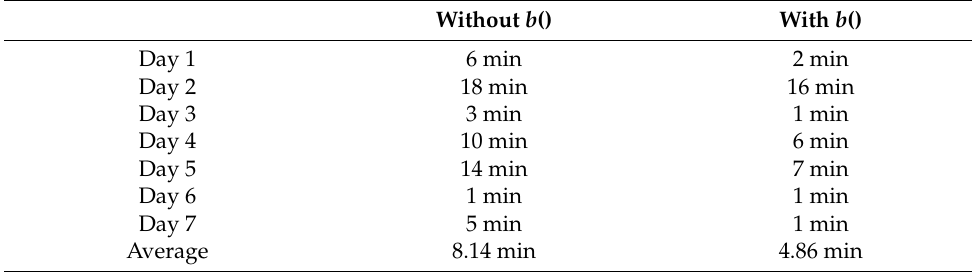
Table 5. Average waiting time from indwelling needle to